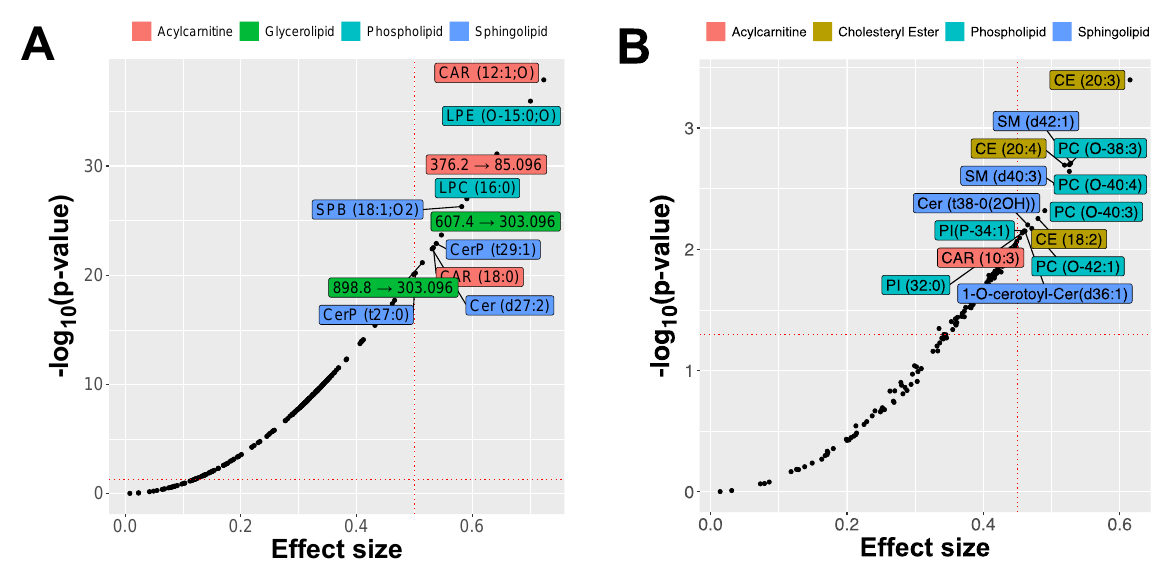
Figure 10. Changes in lipids during treatment identified using linear models; effect size shown as Cohen’s f . ( A ): skin swabs, ( B ): dried blood spots.